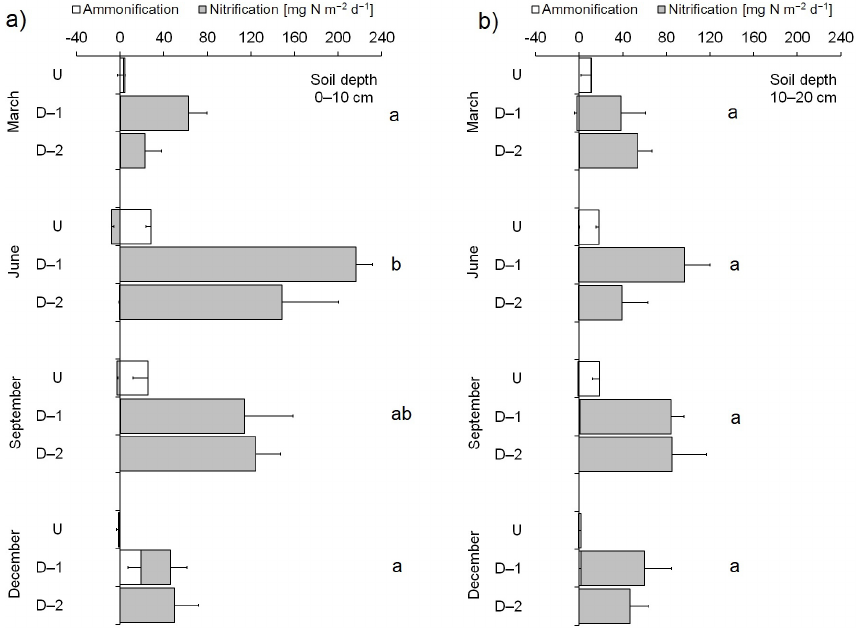
Figure 3. Net ammonification, net nitrification and net N mineralization rates (sum of net ammonification and net nitrification rate) for the soil depth of 0–10cm (a) and 10–20cm (b) . Means ( ± SE; n = 3) followed by the same letter indicates no significant differences in the net N mineralization rate between the months within one soil depth (two-way ANOVA, TukeyHSD test at P ≤ 0 . 05). Differences between both soil depths are not